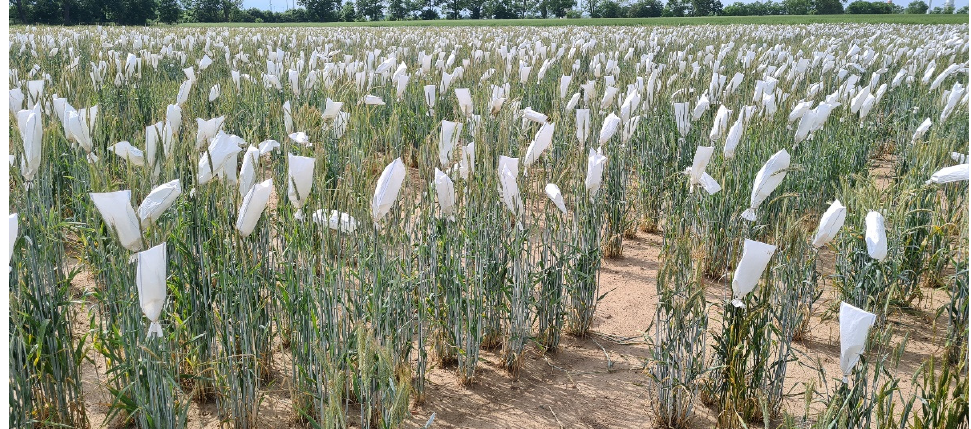
Figure 2. Production of elite rye inbred lines by bagging.